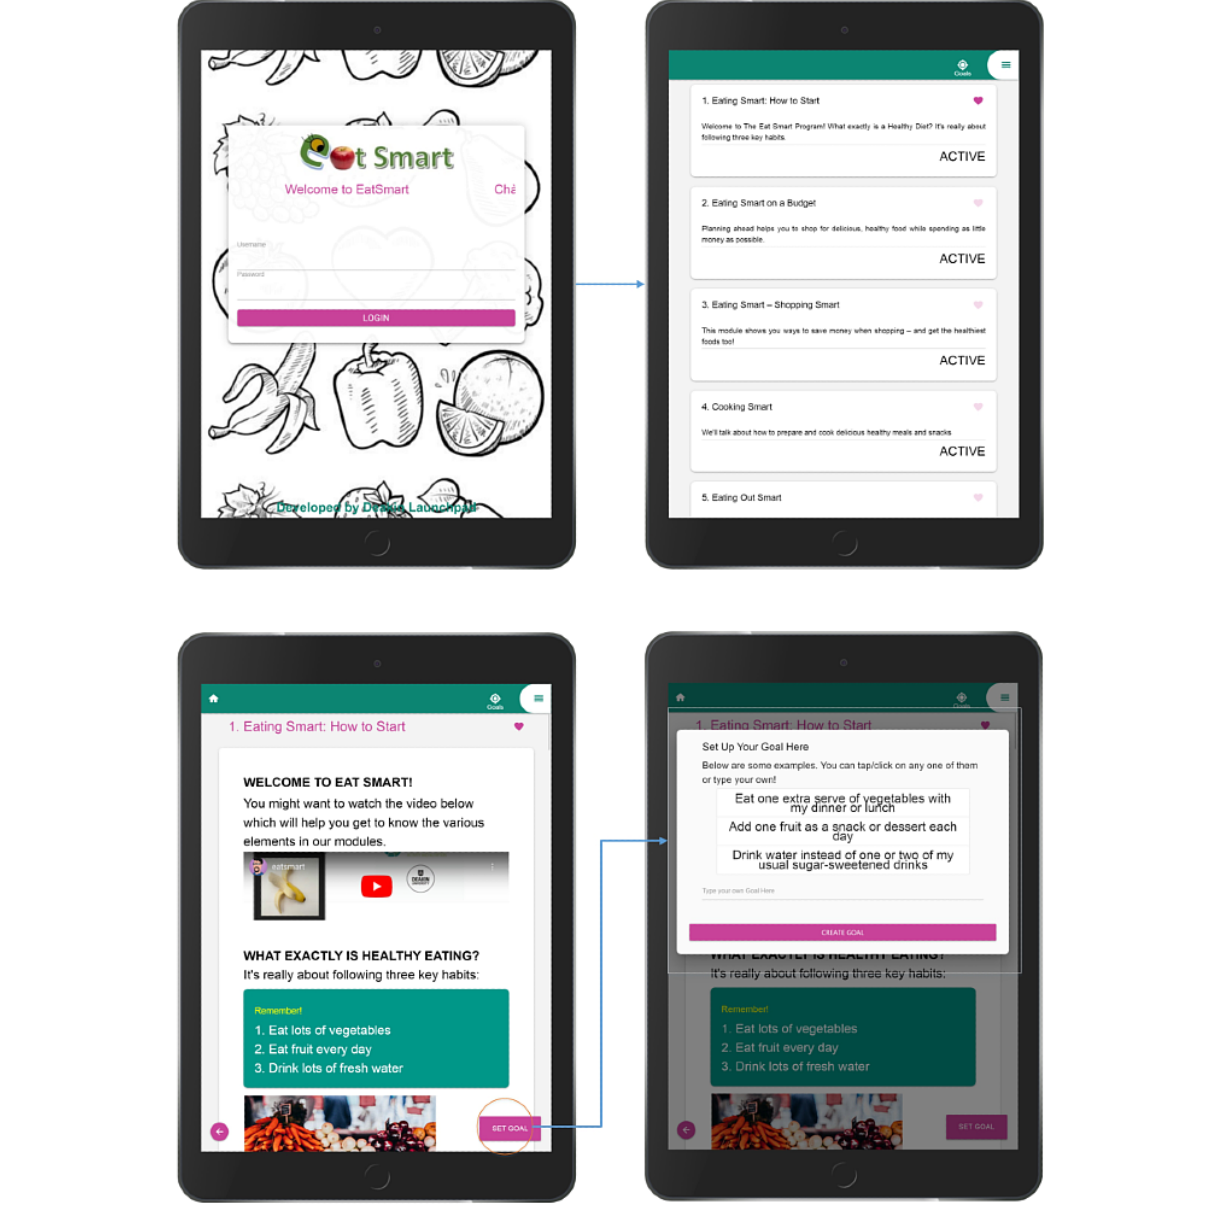
Figure 1. Screenshots of EatSmart